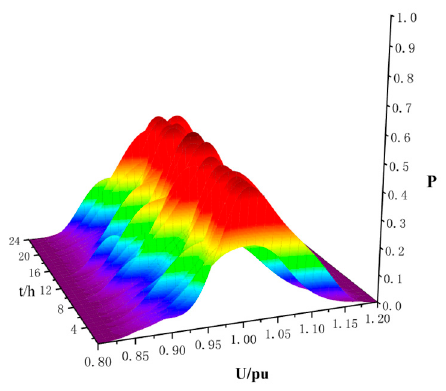
Figure 14. Node 21 coordinated charging PDF.